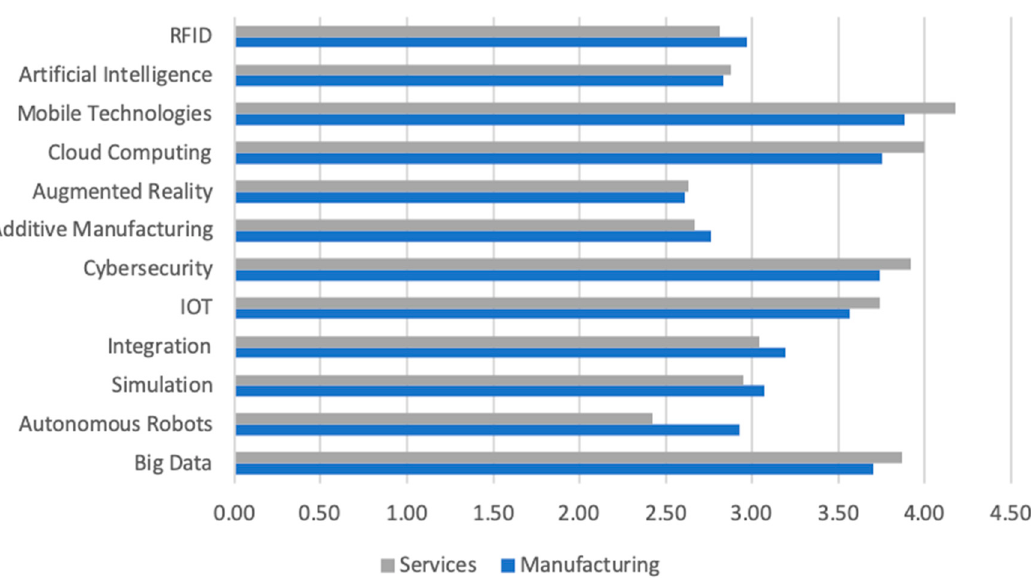
Figure 9. Industry 4.0 technologies (bar chart).